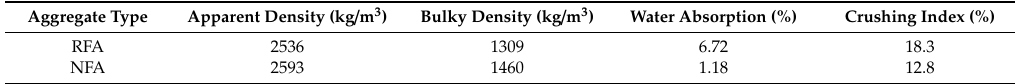
Table 4. Physical properties of RFA and NFA.